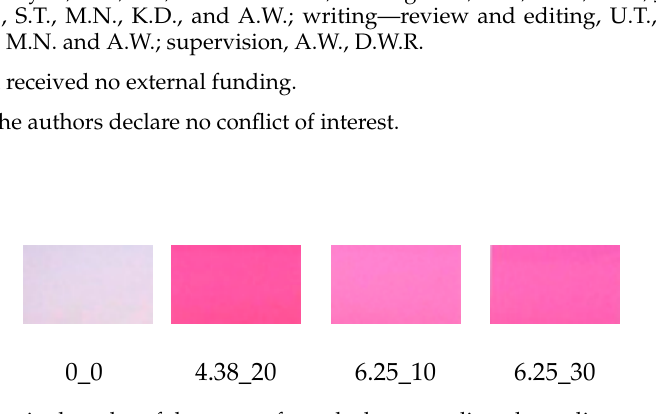
Figure A1. Changes in the color of the extract from the beetroot slices depending on the parameters of the applied pulsed electric field